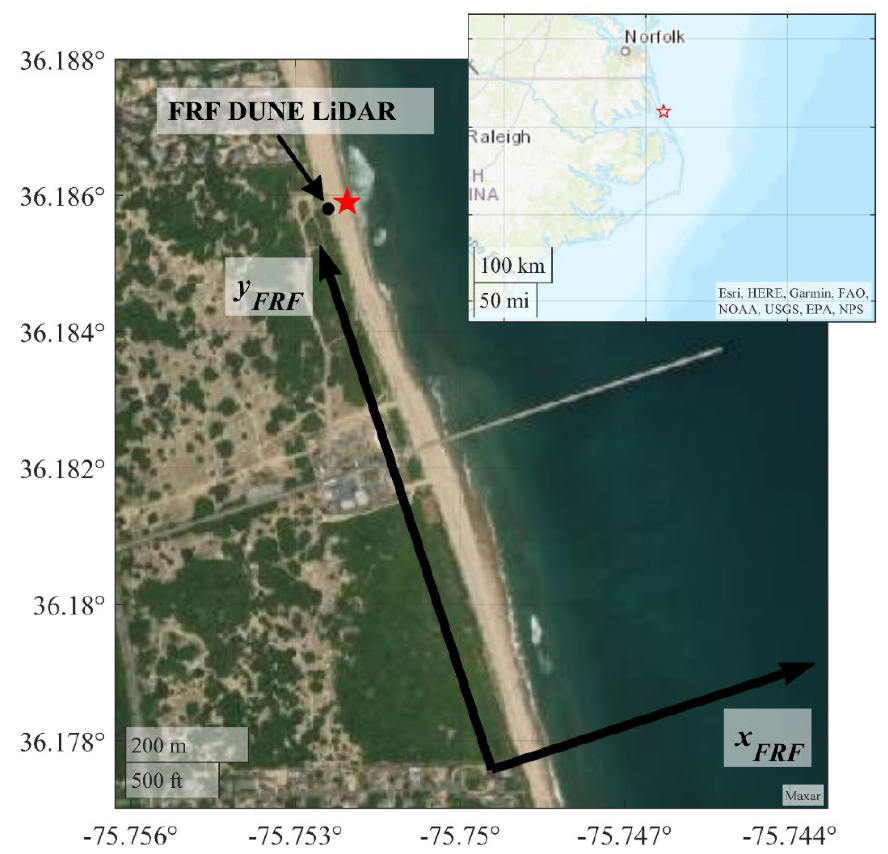
Figure 2. Field location along the Outer Banks of North Carolina, at the USACE FRF in Duck, NC. The local FRF coordinate system ( x FRF , y FRF ) is overlain on the satellite view. The location of the FRF DUNE LiDAR (black circle), and the approximate locations of the LLC LiDAR installations (red star) are shown. The z FRF coordinate is positive following the right-hand rule.